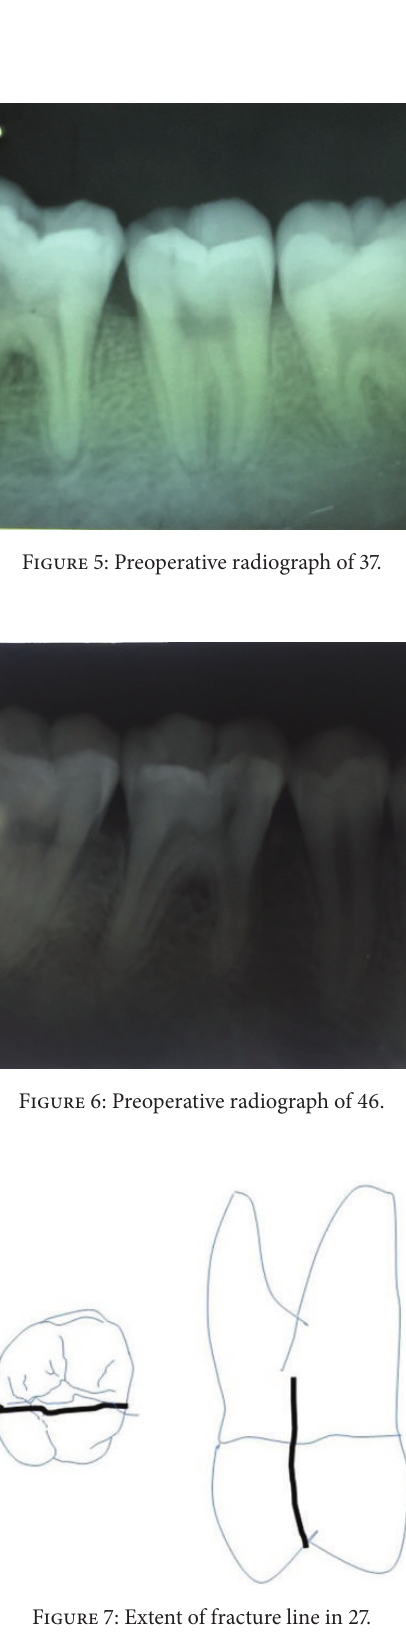
Figure 7: Extent of fracture line in